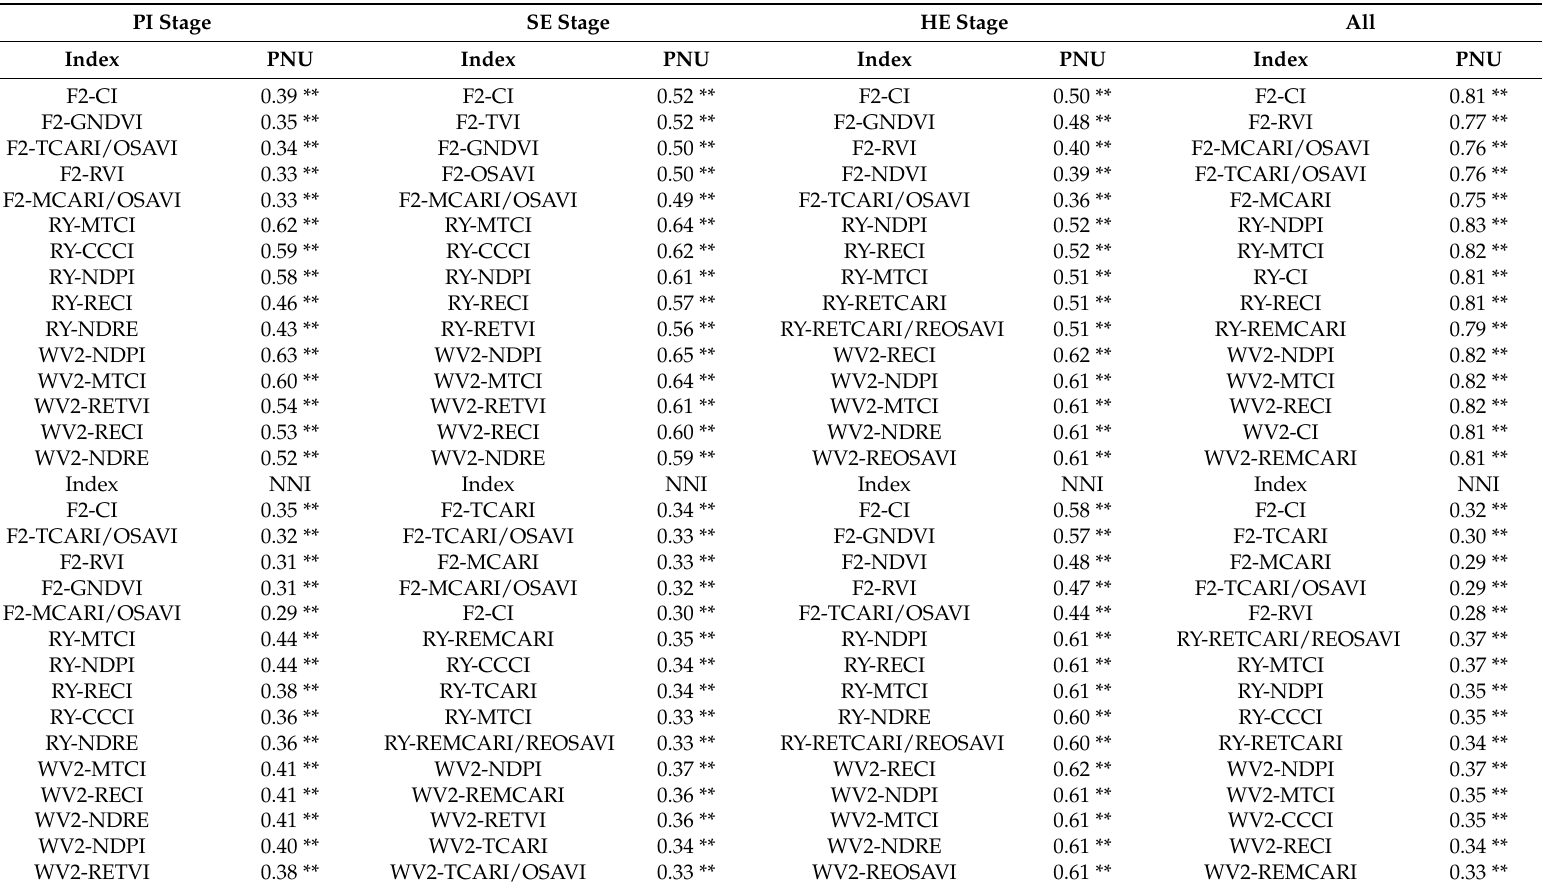
Table 6. The top five coefficients of determination (r 2 ) for the relationships between vegetation indices based on the wavebands of FORMOSAT-2 (F2), RapidEye (RY), WorldView-2 (WV2) and plant N uptake (PNU), nitrogen nutrition index (NNI) at the panicle initiation (PI), stem elongation (SE), heading (HE), and across stages (All), respectively. Only significant r 2 values were